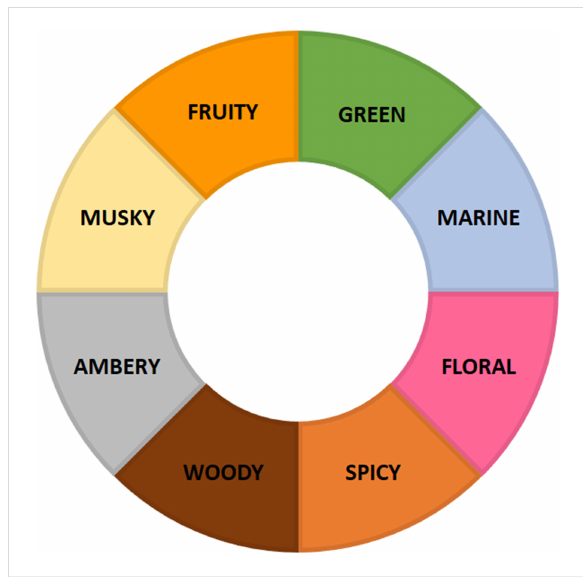
Figure 1: The olfactory spectrum wheel ordering different types of odorants from fruity to musky.